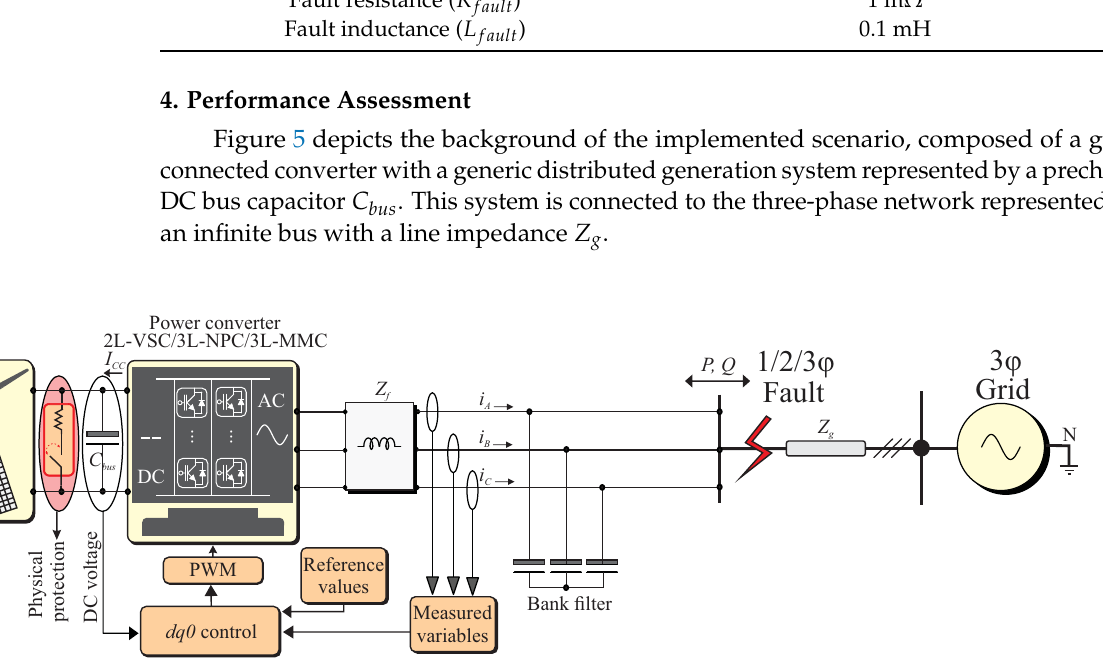
Figure 5. Implemented system